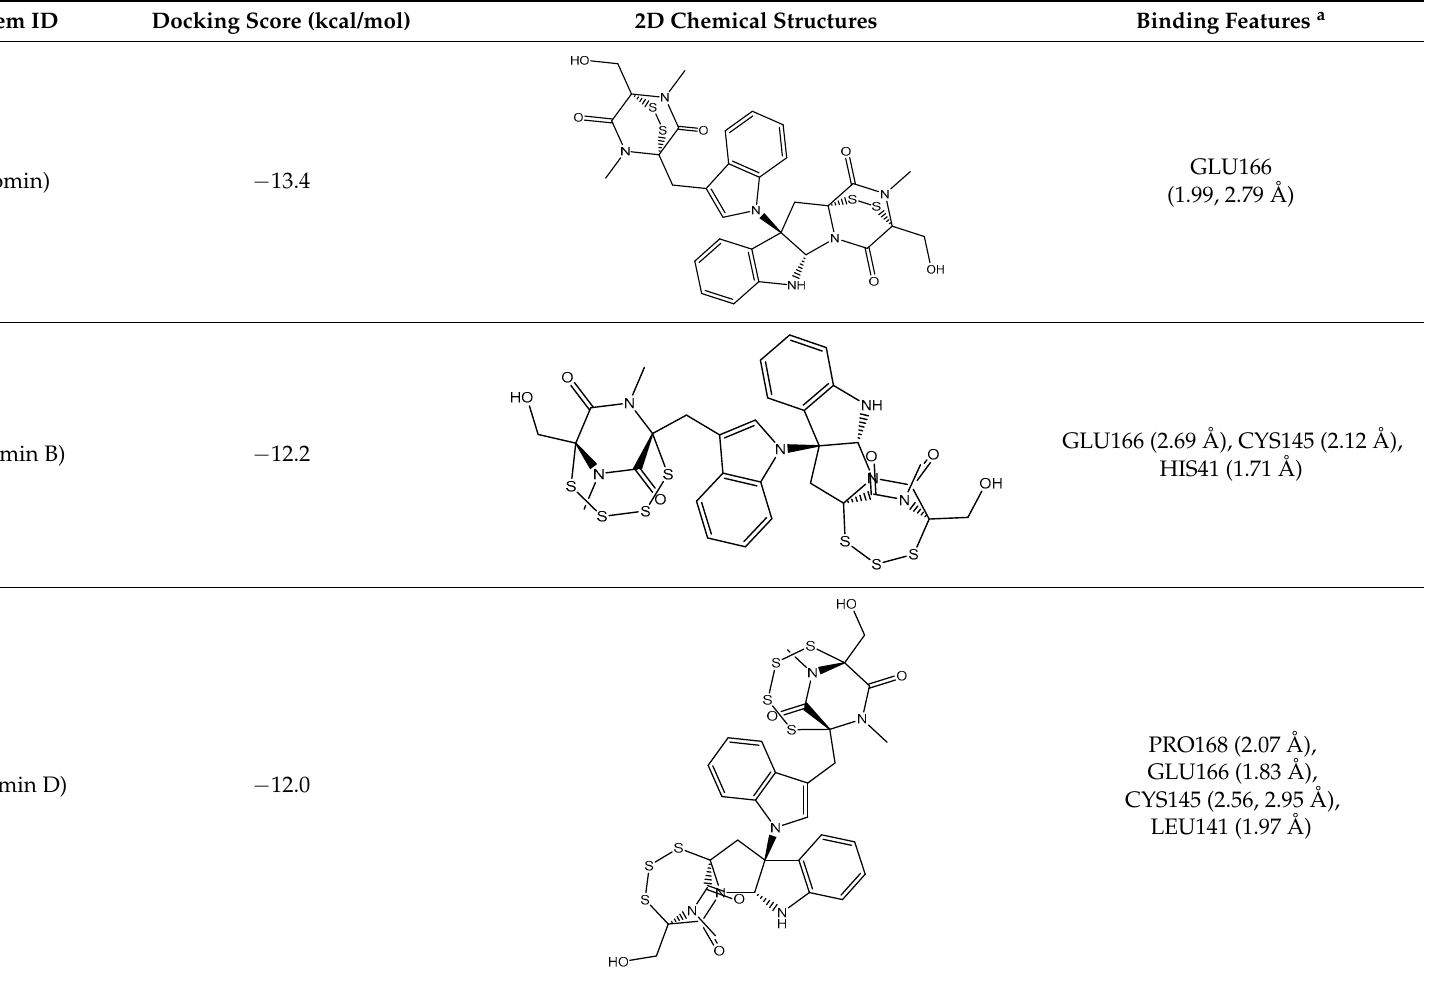
Table 4. Predicted docking scores, binding features, and 2D chemical structures of chetomin analogs as SARS-CoV-2 3CL pro inhibitors.